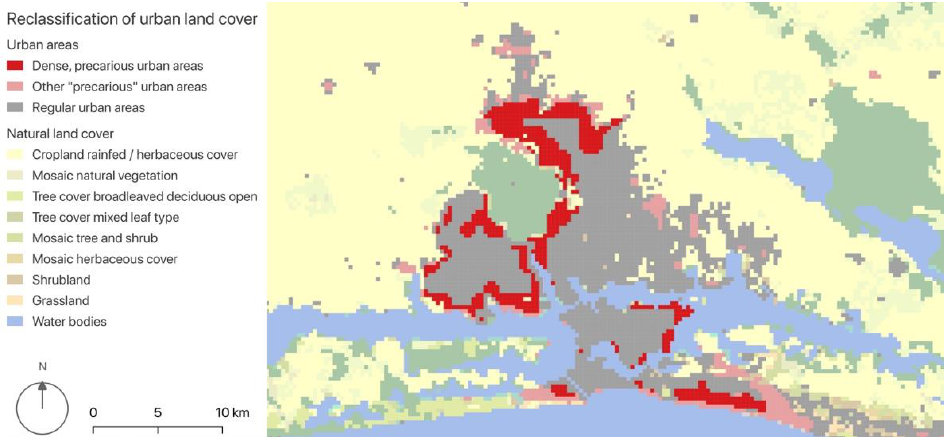
Figure 3. Reclassified urban patches (zoom on Abidjan’s metropolitan area). Elaborated by the authors with QGIS, from: NASA [35], ESA Land Cover CCI [36] and WorldPop [37]. © ESA Climate Change Initiative — Land Cover led by UCLouvain (2017).